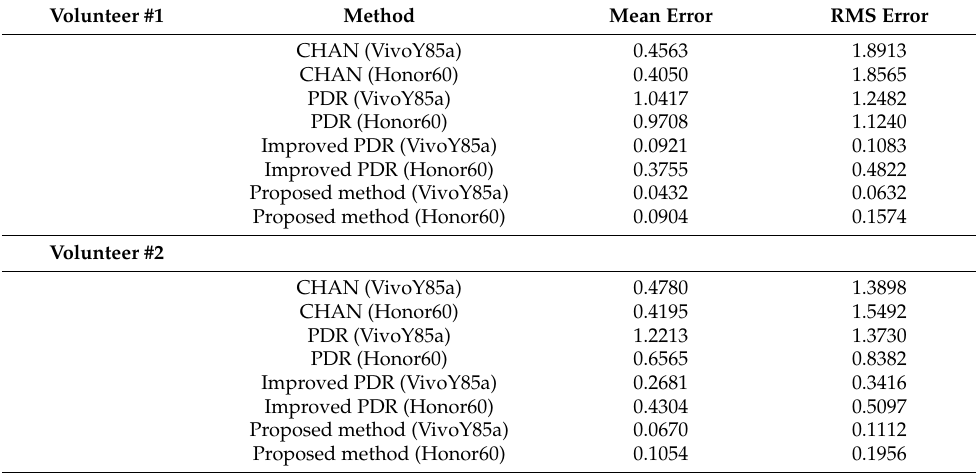
Table 7. Localization error results between CHAN, PDR, improved PDR, and the proposed method with Honor60, VivoY85a, and two different height pedestrians in the first scene (m).